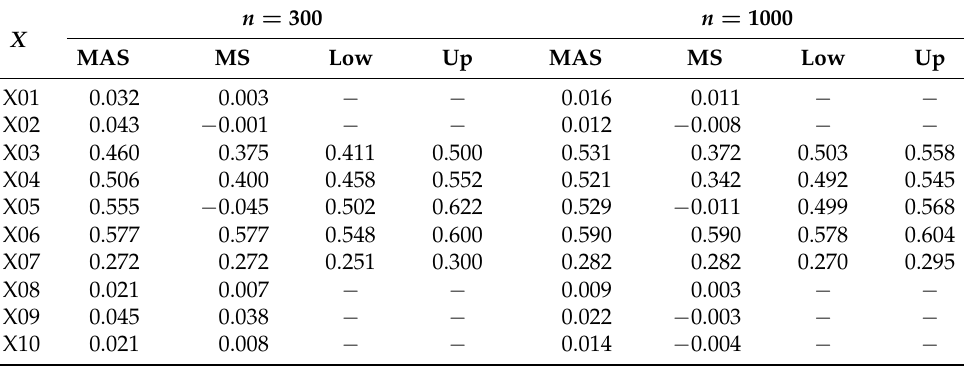
Table 6. Model M3 (Friedman), mean absolute sensitivity (MAS), mean sensitivity (MS), lower (Low) and upper (Up) bootstrap confidence interval limits with B = 1999 replicates and nominal level 1 − α = 0.90, for n = 300, and n = 1000 observations. For those variables that were not relevant, no confidence limits are